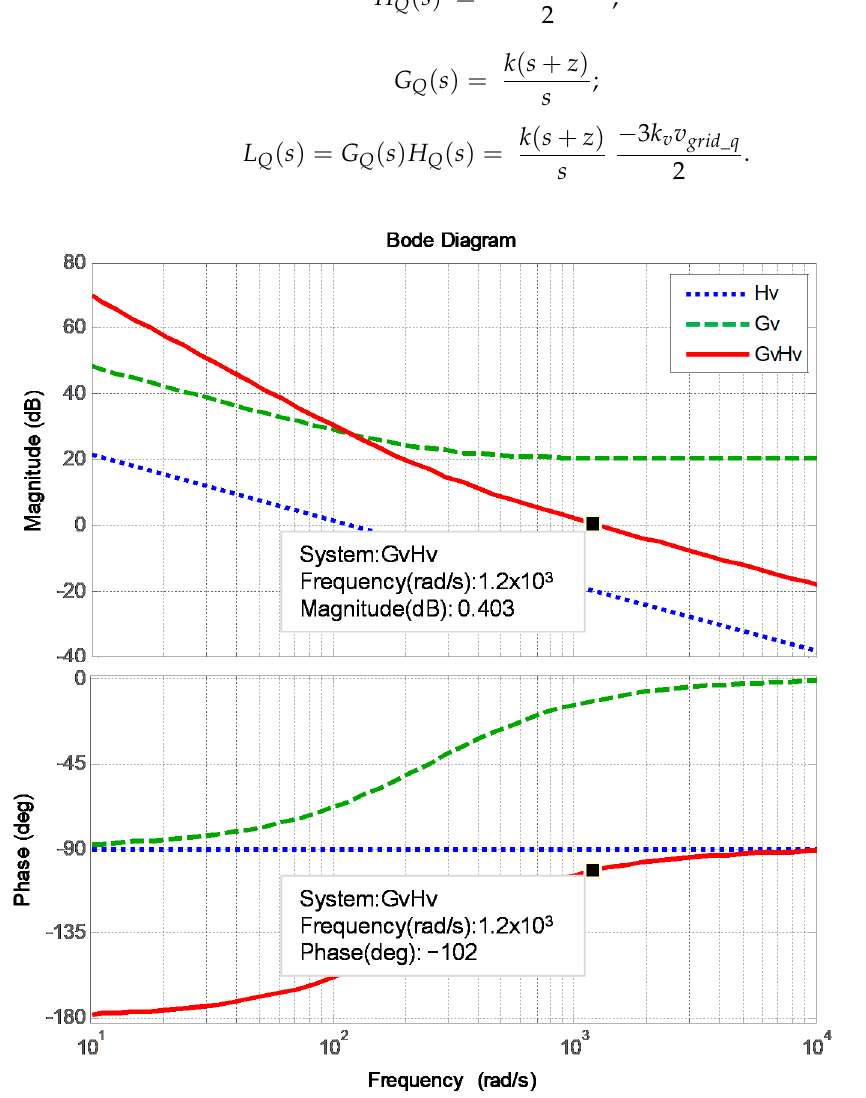
Figure 9. Bode plot of the DC link voltage control loop.